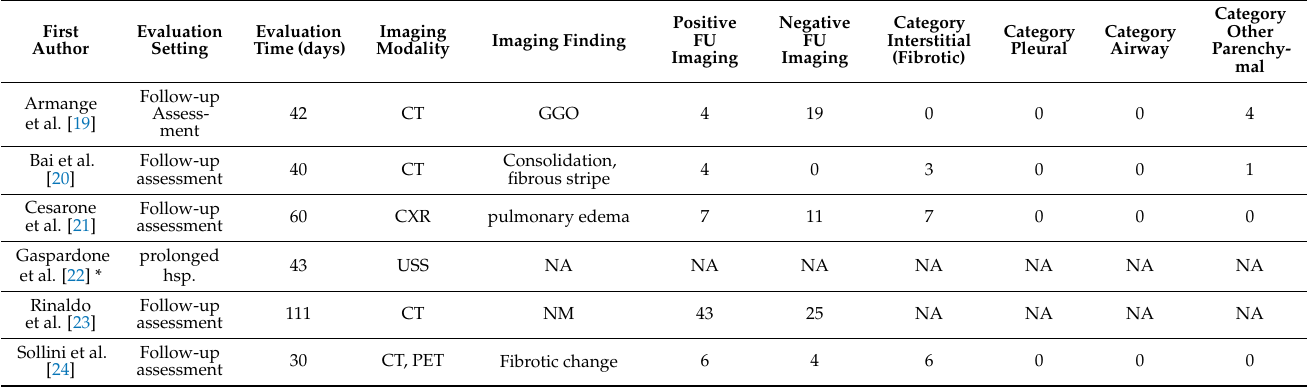
Table 3. Imaging modalities and imaging findings of the included case-control and cohort